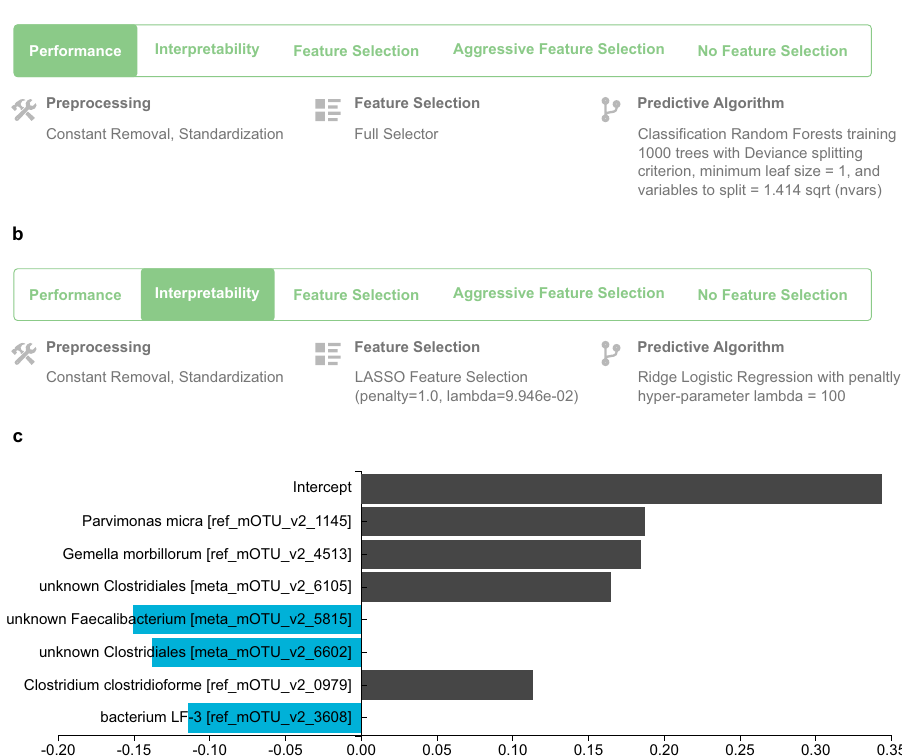
Fig. 1 The best performing and best interpretable model trained on the China (CN) cohort. a Winning con fi guration that leads to the production of the fi nal best-performing model when applied to all training data. It is produced by fi rst applying removal of constant-value features and standardization of all features, followed by including all features in the model (FullSelector, i.e., no feature selection), and then modeling using the Random Forest algorithm. The hyper-parameter values to use are also shown. b Con fi guration that leads to the production of the best interpretable model. It is a linear Ridge Logistic Regression type of model, preceded by a Lasso regression for feature selection. c The interpretable model can be visualized, in contrast to the best-performing one. JADBio shows the standardized coef fi cients of the model for each selected feature and the intercept